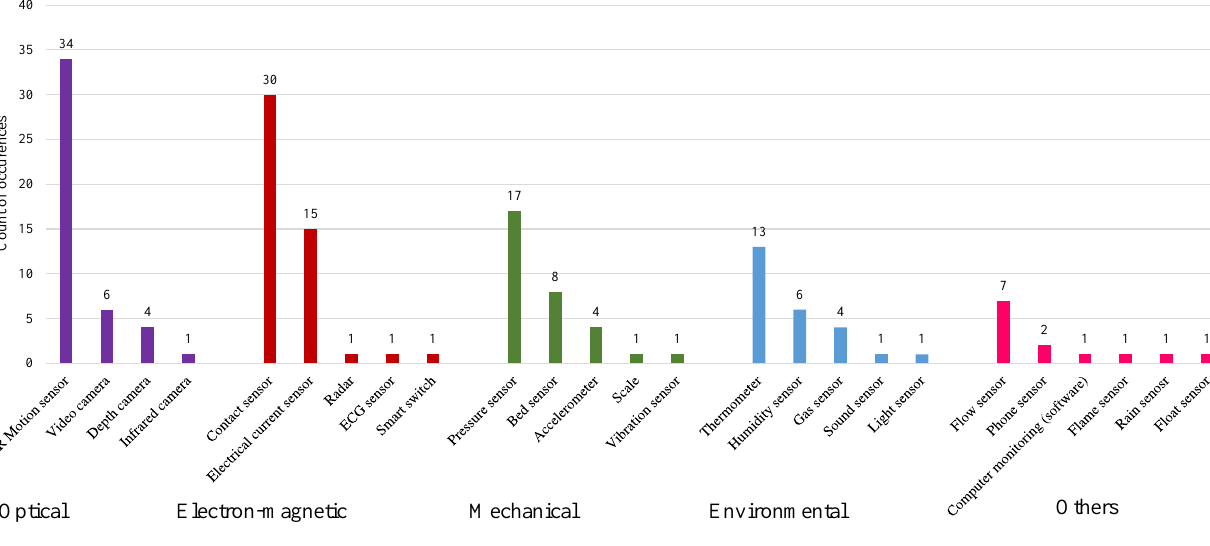
Figure 4. Distribution of sensor